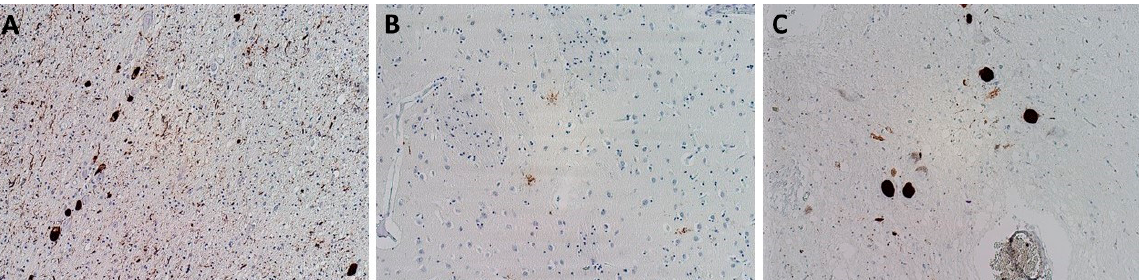
Figure 4. Tau pathology spectrum in various brain areas in progressive supranuclear palsy. ( A ) Numerous threads, coiled bodies, and neurofibrillary tangles in subthalamic region, stained with monoclonal antibody (AT8) against hyperphosphorylated tau protein; ( B ) Tufted astrocytes in the basal ganglia, stained with monoclonal antibody (AT8) against pathologically changed tau protein; ( C ) Neurofibrillary tangles in the substantia nigra neurons, stained with monoclonal antibody (4RD) against tau protein, original magnification 100×.